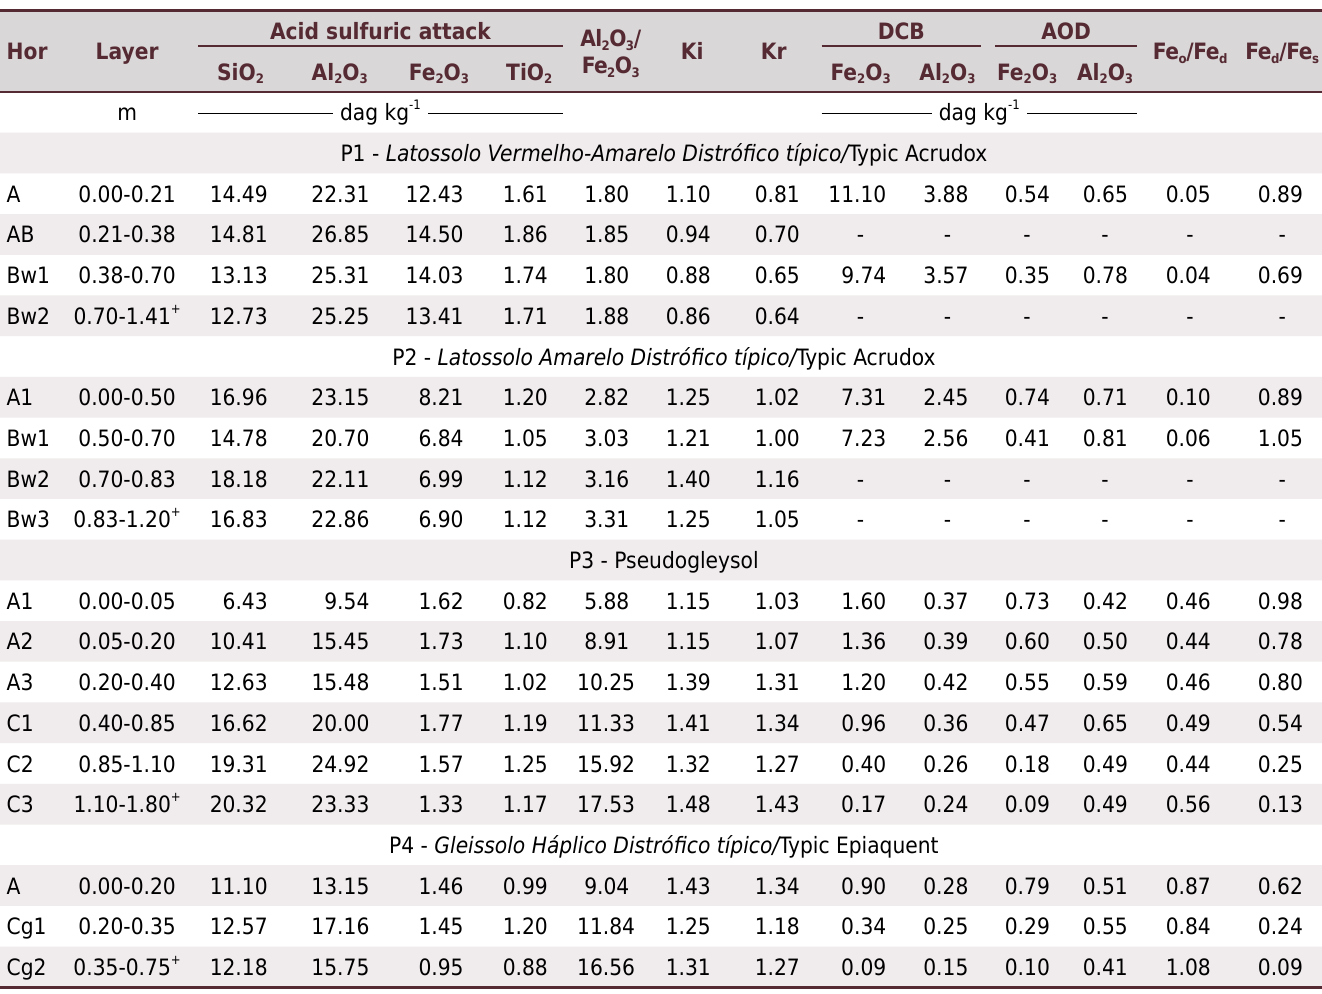
Table 3. Results of acid sulfuric attack, dithionite-citrate-bicarbonate (DCB), acid oxalate method at darkness (AOD), and molar ratios Acid sulfuric Hor Layer